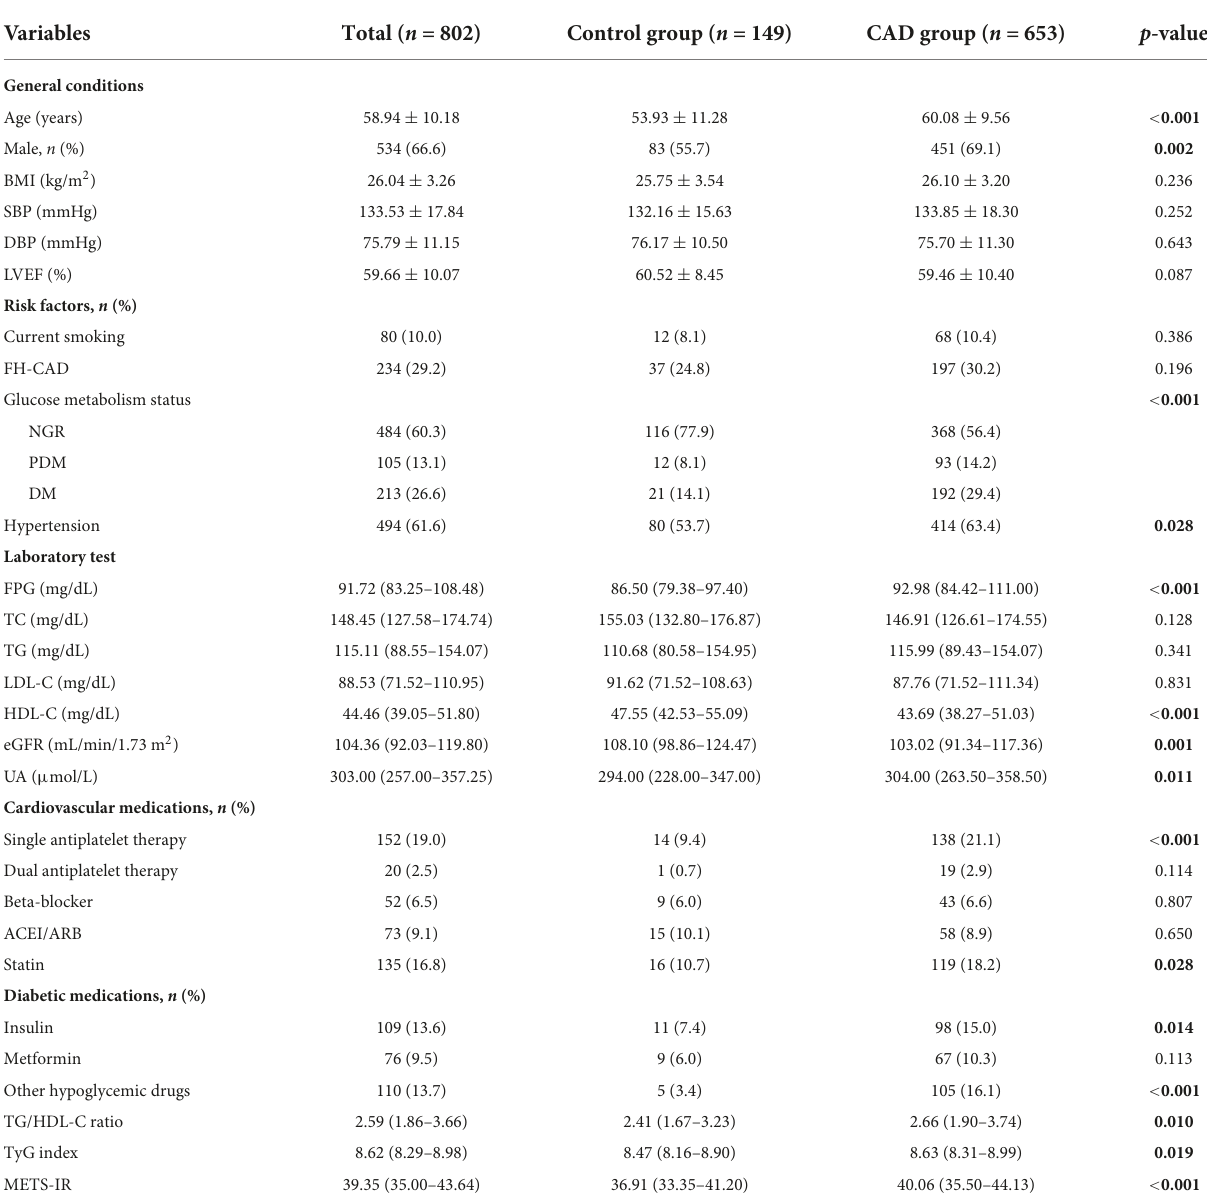
TABLE 1 Baseline characteristics of the study